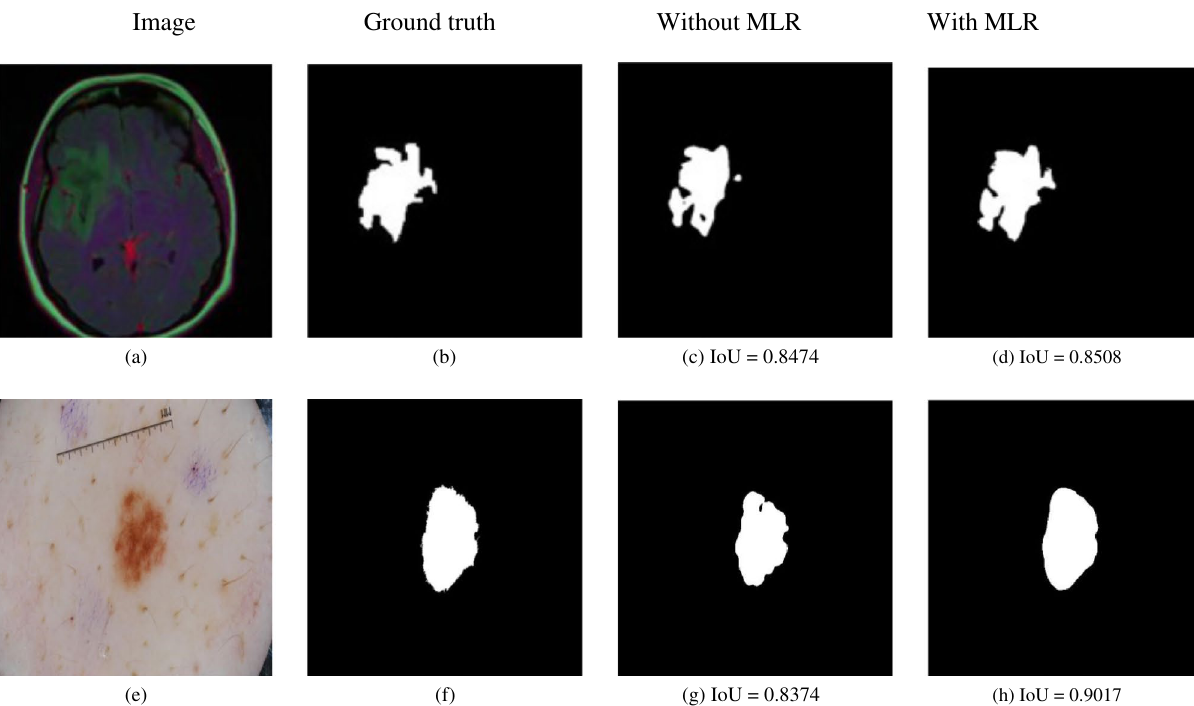
Figure 6. Two visual examples from the MRI 15 (a) and the dermoscopy 11,12 (e) images; and their corresponding ground truth masks (b,f) showing that the presence of the MLR blocks in the skip connections of the MILDNet enhances the segmentation accuracy, with the ground truths given in 6b and 6f. The predicted masks for the skip connections with the MLR blocks (d,h) preserved the continuity in the boundaries. The skip connections without the MLR blocks (c,g) resulted in the loss of some valuable information about the boundaries and the ROI